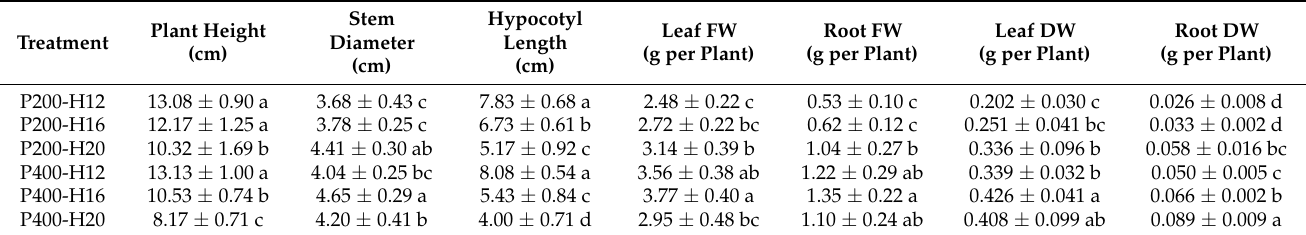
Table 3. Leaf morphology and carbohydrate accumulation of cucumber seedlings grown for 21 days after sowing, as impacted by photosynthetic photon flux density (P) and photoperiod (H) with different daily light integrals (DLIs) in a closed transplant production